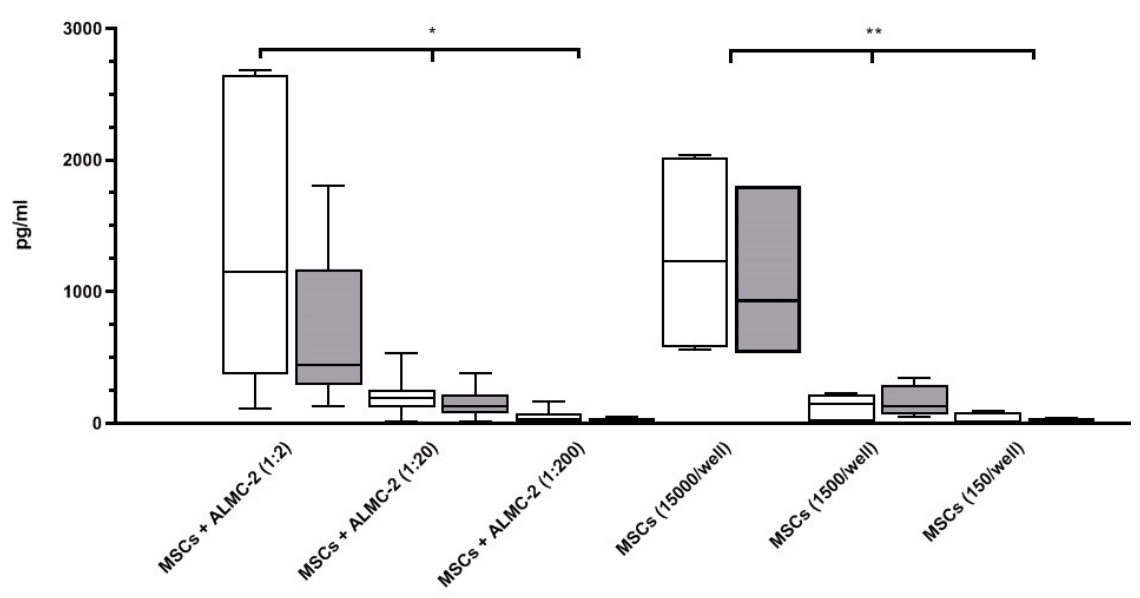
Figure 7. IL-6 production in AL- and HD-MSC co-culture supernatants. Evaluation of IL-6 production by AL-MSCs (white bar) and HD-MSCs (grey bar) after co-culture with ALMC-2 cells at different ratios in DMEM complete medium. IL-6 was also quantified in the supernatants of AL- and HD-MSCs alone at the same number of MSCs for the different ratios. Results, expressed as pg/mL, are shown as median [25–75%, Min-Max]. * p = 0.01 for all, ** p = 0.003 for all.